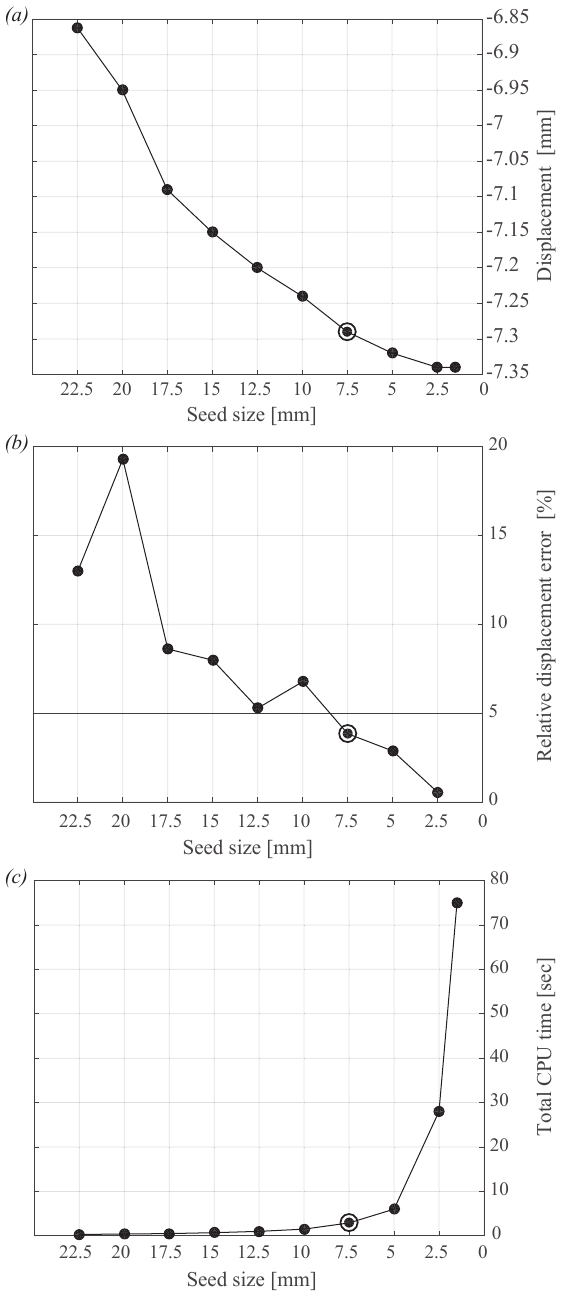
Figure A2. Mesh seed size convergence with respect to displacement results ( a ). Relative displacement error of the consecutive refinement ( b ). Total computation time needed for the analysis ( c ). Chosen seed size is marked with a